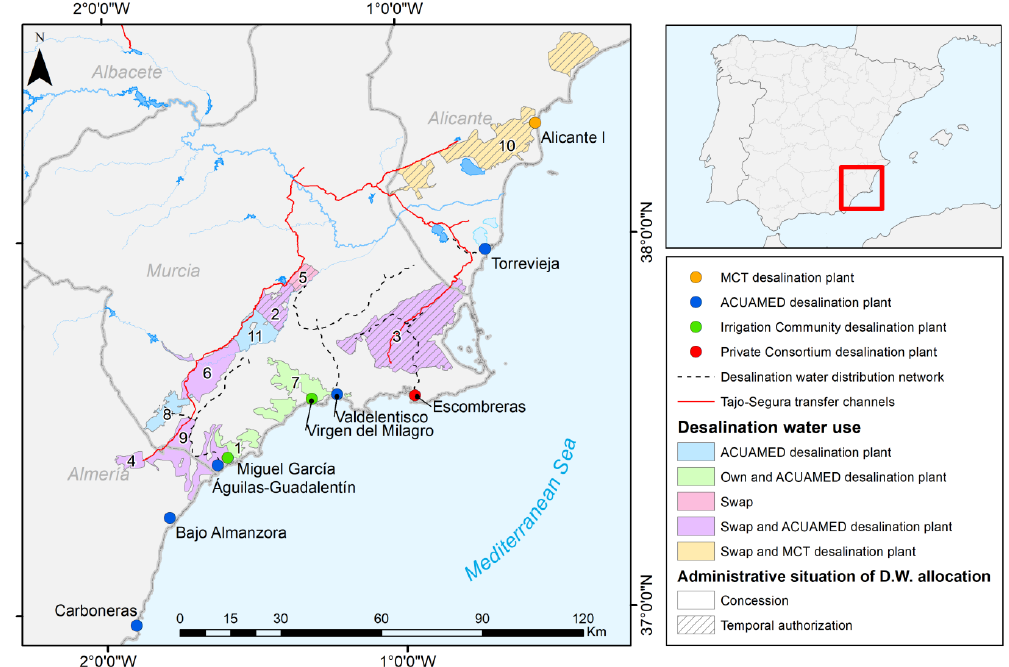
Figure 2. Study area location and group of irrigation communities according to their use of desalinated water. Irrigation communities: 1. Á guilas; 2. Alhama de Murcia; 3. Campo de Cartagena; 4. El Saltador; 5. Librilla; 6. Lorca; 7. Mazarrón; 8. Puerto Lumbreras; 9. Pulpí; 10. Riegos de Levante; 11.